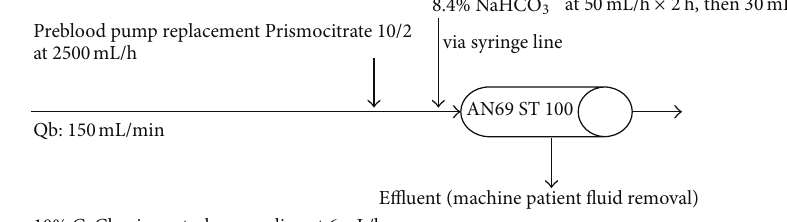
Figure 1: Diagram of predilutional continuous venovenous hemofiltration using Prismocitrate 10/2 solution and Prismaflex machine.